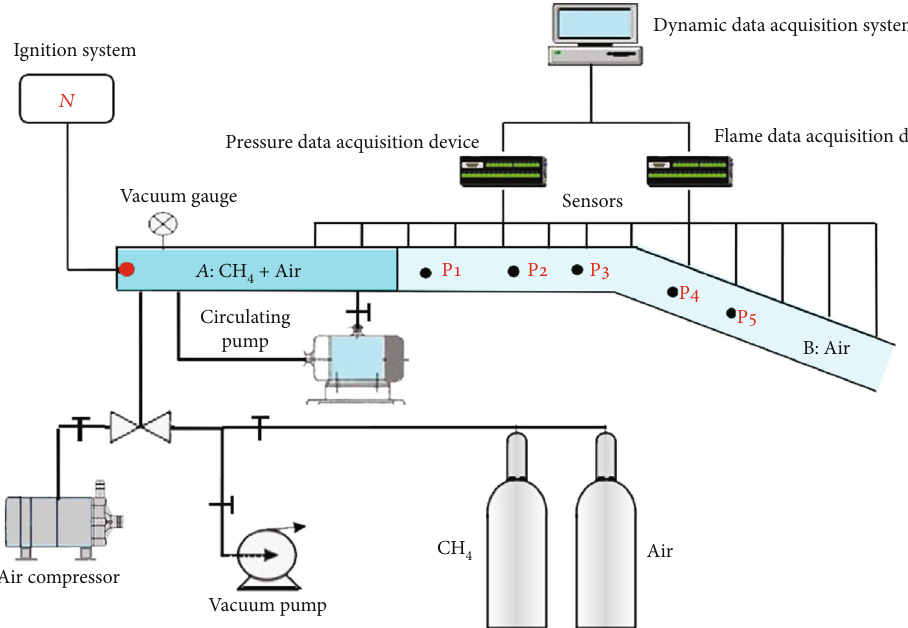
Figure 1: Gas explosion experimental